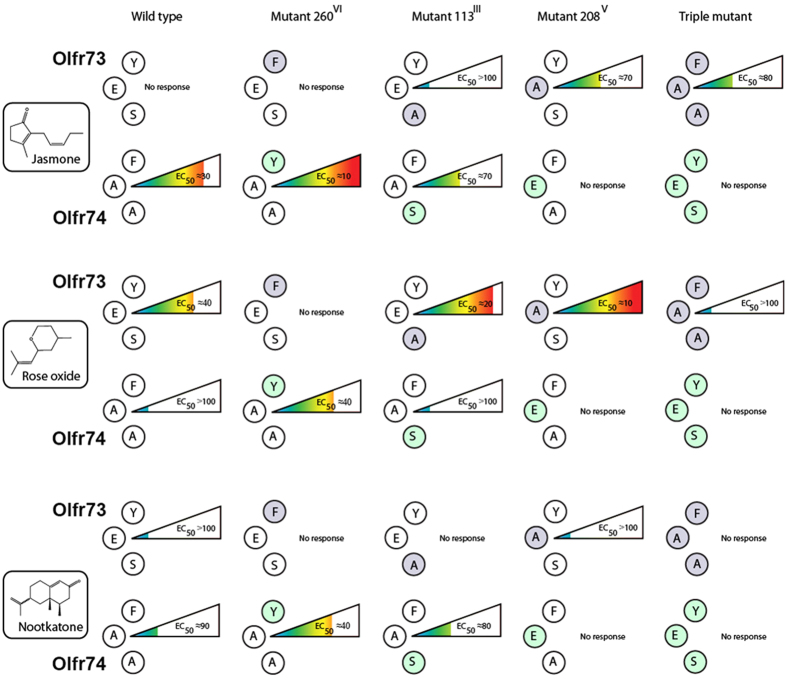
Potency of different odorants on Olfr73 and Olfr74 wildtype and mutant receptor activation.Schematic representation of the potency of jasmone, rose oxide and nootkatone in activating Olfr73, Olfr74 wildtype receptors and the corresponding point mutants in positions 113, 208 and 260. Specific amino acid changes are highlighted with grey and green shaded circles. Roman numbers indicate numbers of trans-membrane helices. The potency of OR activation is illustrated with a rainbow color spectrum ranging from blue corresponding to a low efficacy values (EC50 > 100 μM) to red corresponding to high efficacy values (EC50 = 10 μM). No response: no receptor activation detectable in the reporter assay. Corresponding dose response curves are shown in Supplementary Fig. 3 and Supplementary Fig. 4.